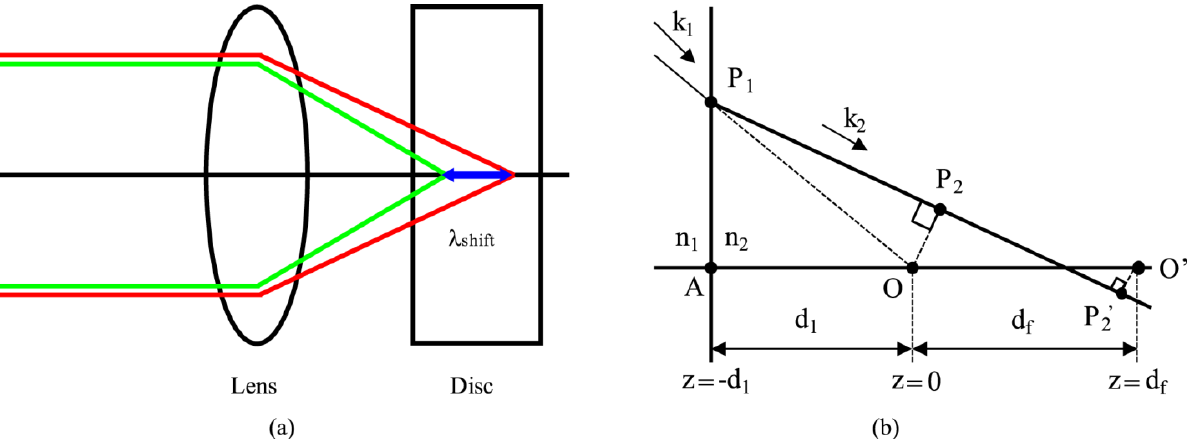
Figure 3. Scheme of focal shift associated with ( a ) wavelengths and ( b ) refractive